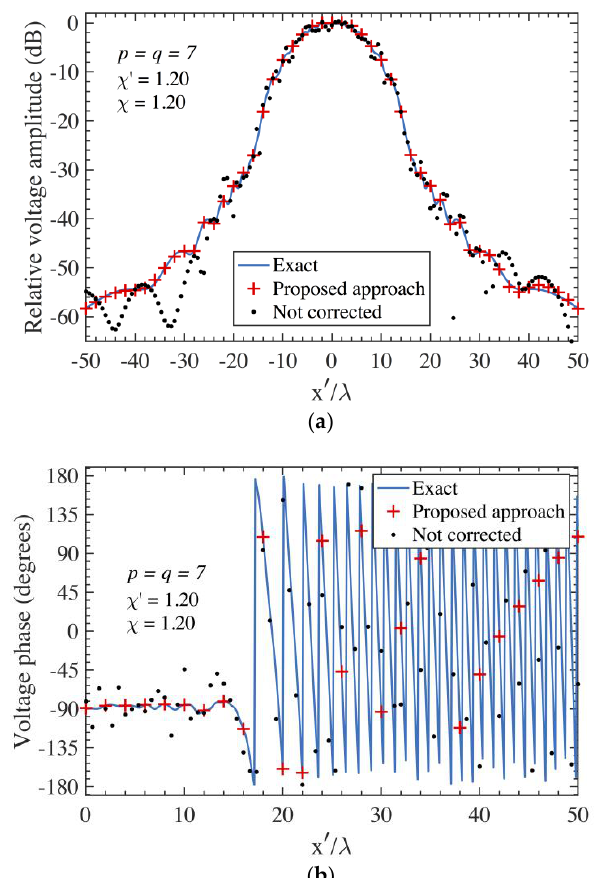
Figure 4. V y on the scanning plane at y ' = 3 λ − AUT 2. Blue line: exact. Red crosses: obtained from the positioning errors corrupted PWMS samples by using the devised multi-steps procedure. Black dots: obtained from the positioning errors corrupted PWMS samples without using the devised procedure. ( a ) Amplitude. ( b ) Phase.